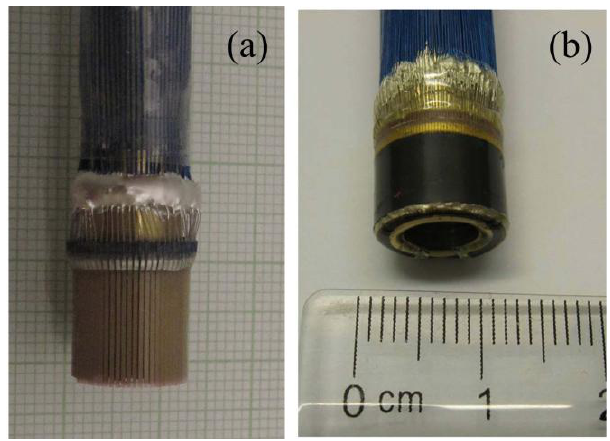
Figure 22. Photographs of the radial array transducers with ( a ) PMN-PT/epoxy 1-3 composite (Structure 1); and ( b ) PMN-PT single crystal (Structure 2) (with permission from